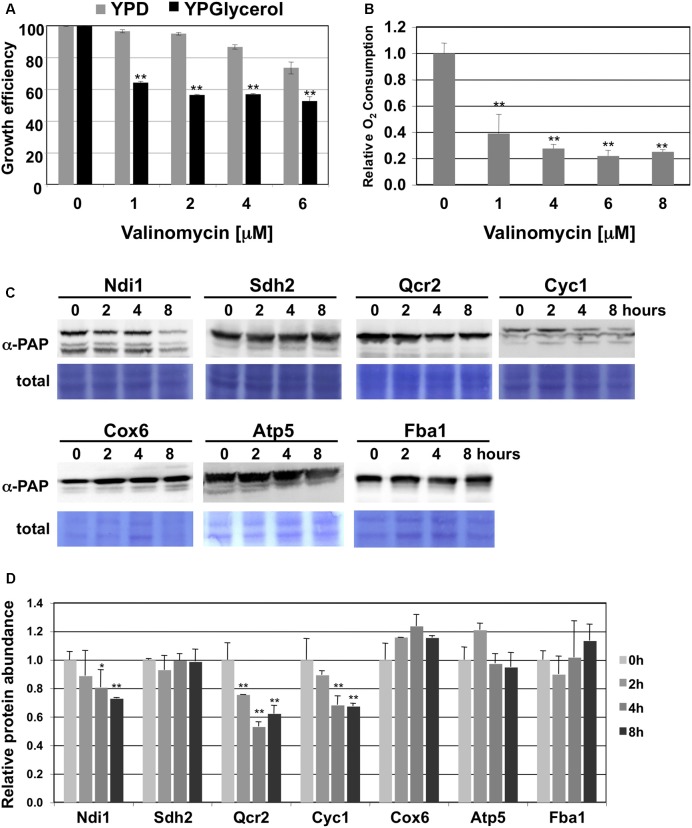
CI and CIII subunits of the mitochondrial electron transport chain are preferentially degraded upon valinomycin stress. (A) Comparison of the growth inhibition of yeast wild type cells by valinomycin upon fermentative (YPD) or respiratory (YPGlycerol) conditions. The growth of three independent cultures was continuously analyzed for each condition. Mean values are depicted including the standard deviation. ∗∗p < 0.01 (Student’s t-test). (B) Effect of valinomycin treatment on the O2 consumption rates of yeast wild type cells. Cells were grown in galactose containing medium and then treated with the indicated doses of valinomycin. Data are mean values from three independent measurements with the standard deviation. ∗∗p < 0.01 (Student’s t-test). (C) Subunits of CI and CIII are selectively degraded upon valinomycin treatment. Whole cell extracts of yeast strains expressing the indicated subunits as TAP fusion proteins were analyzed by western blot during the treatment with 4 μM valinomycin in galactose containing media. Ndi1 (CI), Sdh2 (CII), Qcr2 (CIII), Cyc1 (CIII), Cox6 (CIV) and Atp5 (CV) were used as representatives of the mitochondrial electron transport complexes. Fba1 served as a glycolytic enzyme control. α-PAP indicates the detection of TAP fusion proteins. Representative blots are shown from a total of three independent experiments. (D) Quantification of the protein abundance upon the conditions described above. The standard error is shown based on three independent experiments. Significantly different degradation rates are marked: ∗p < 0.05; ∗∗p < 0.01 (Student’s t-test).